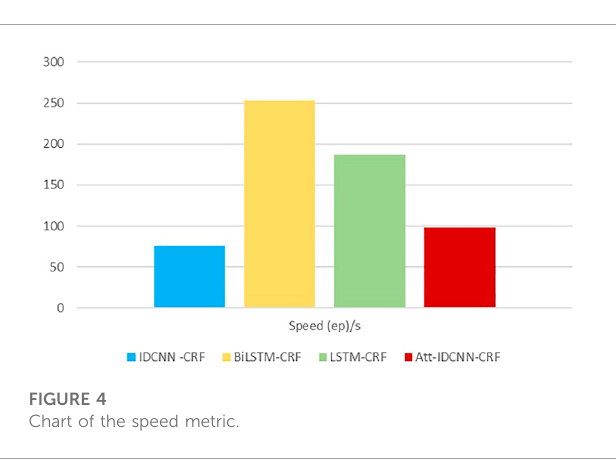
FIGURE 4 Chart of the speed